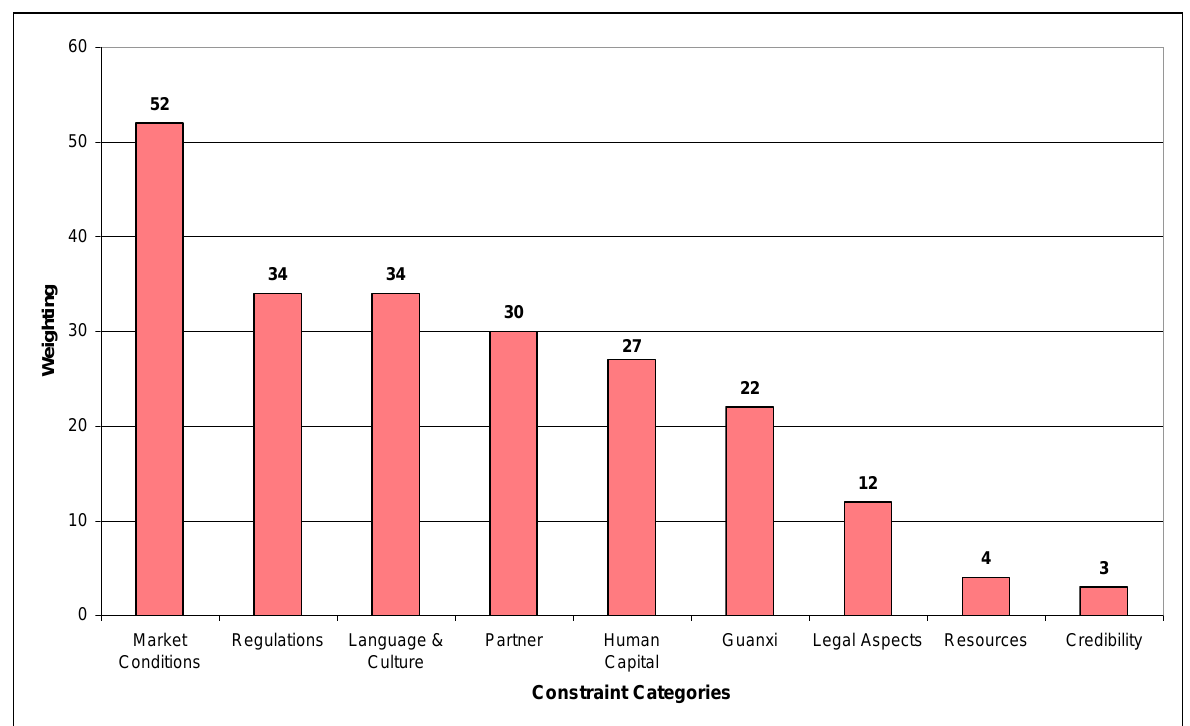
Figure 2: Constraint clusters and aggregate